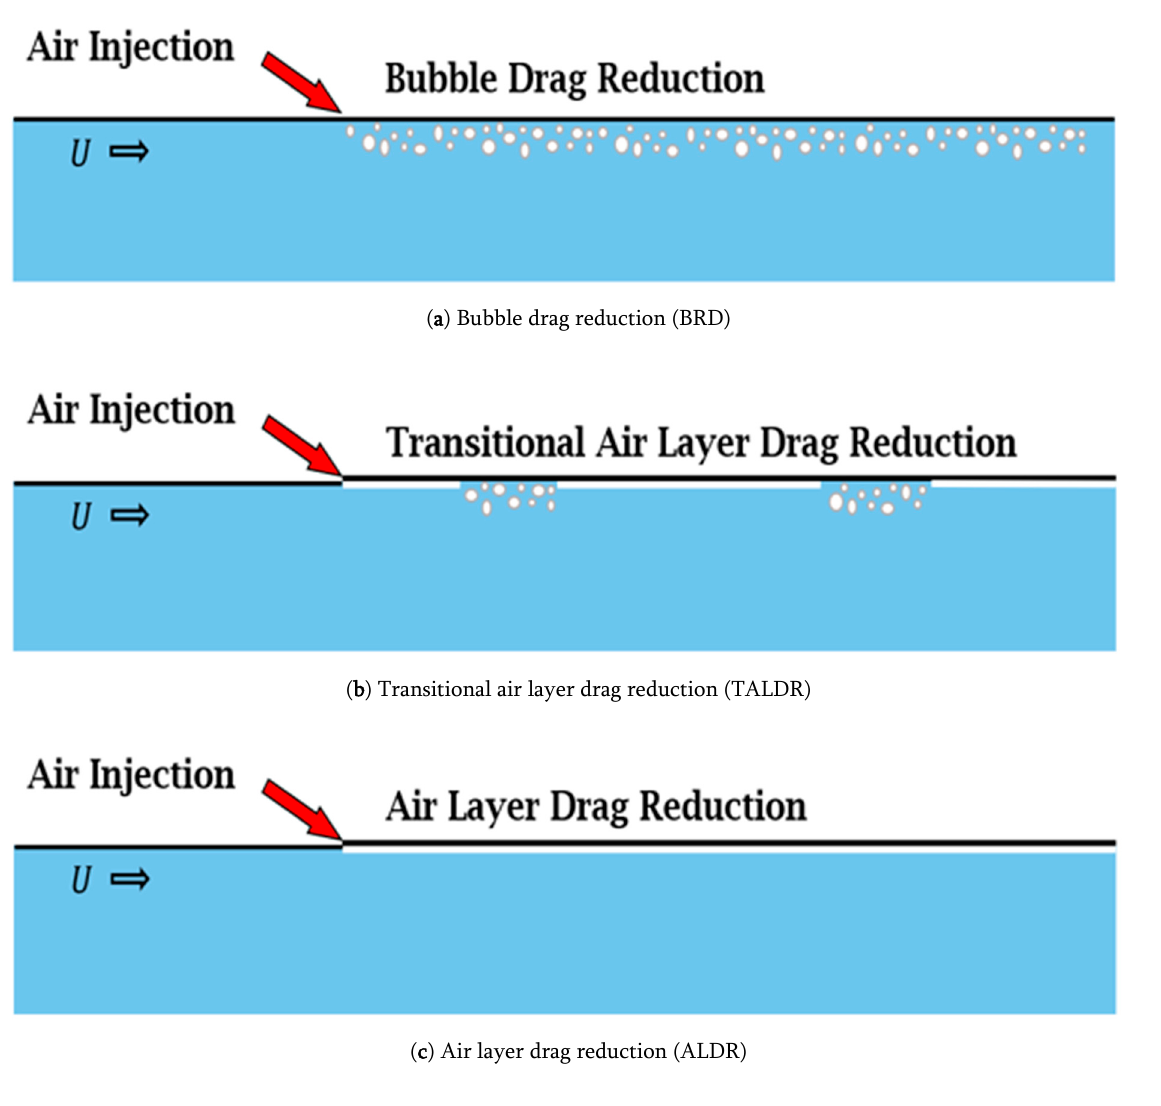
Figure 1. Three shapes of air layer. Reprinted from Ref.